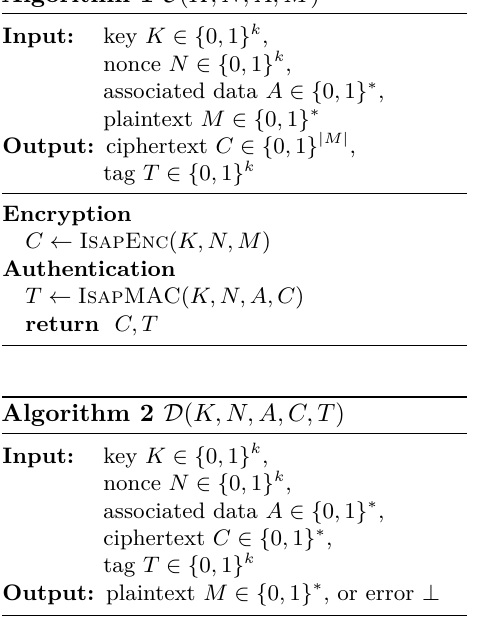
Algorithm 4 IsapRK ( K, Y, IV , z )